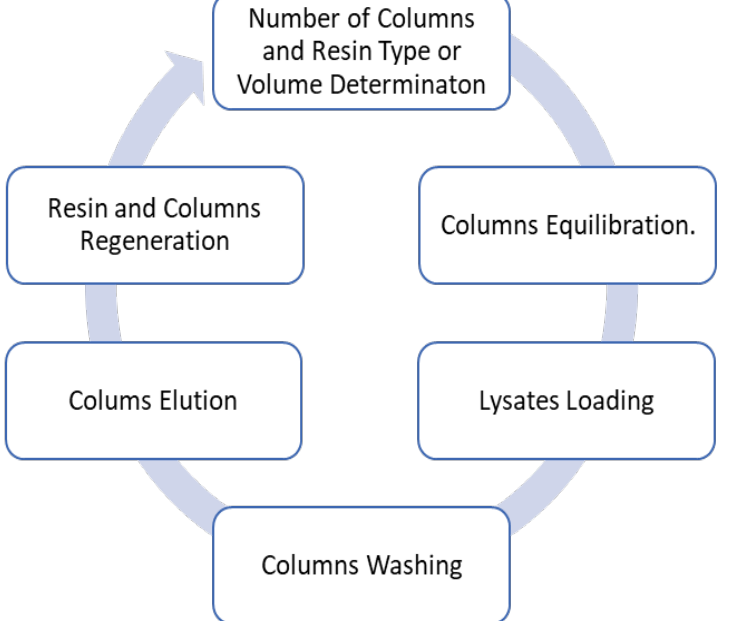
Figure 3. Purifying yeast AbpSH3 mutants using affinity chromatography with Ni resin and MCPA under summarised vacuum process protocols [9].